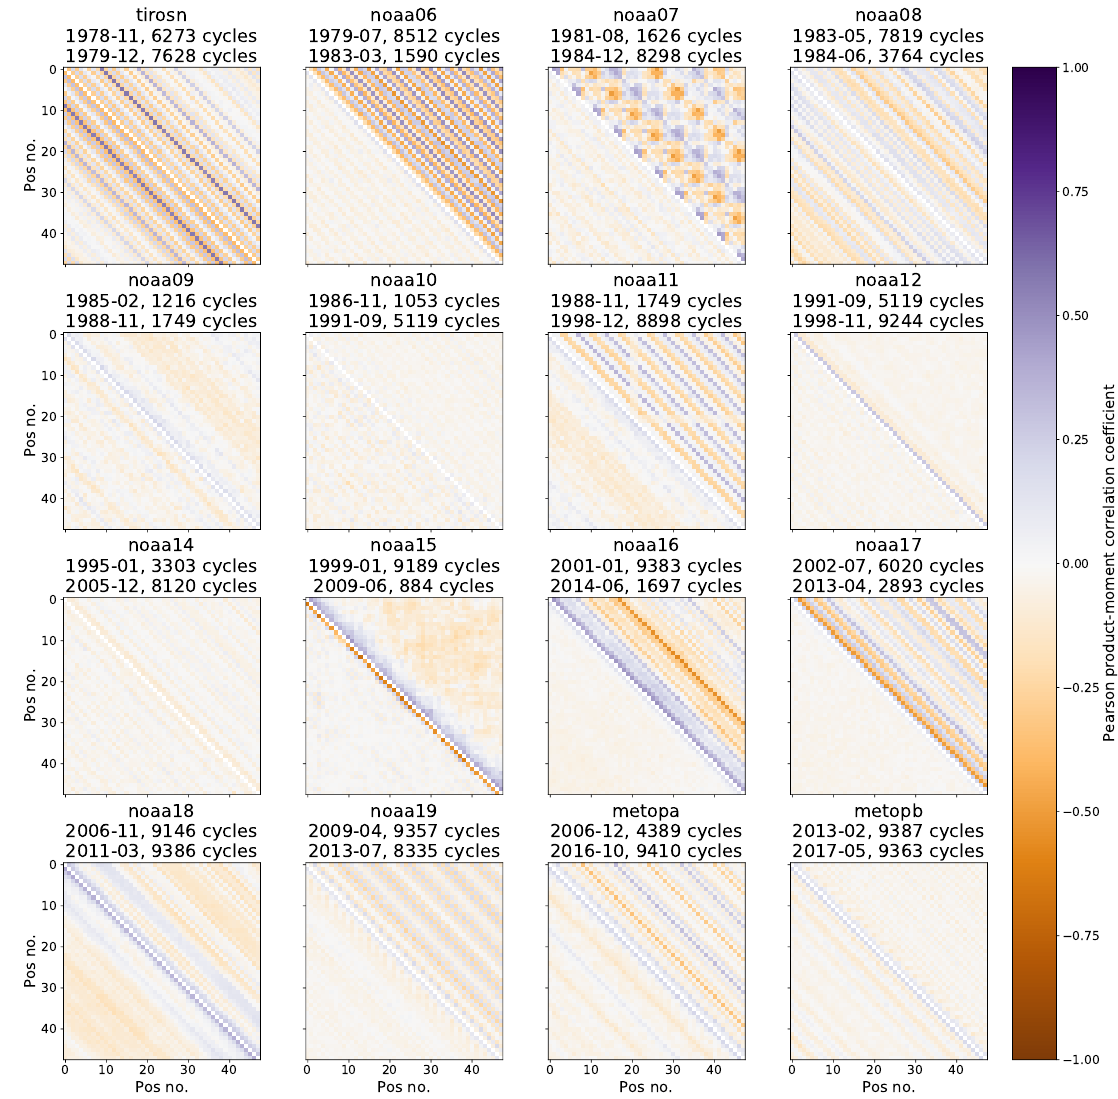
Figure 8. Like Figure 7, but for channel